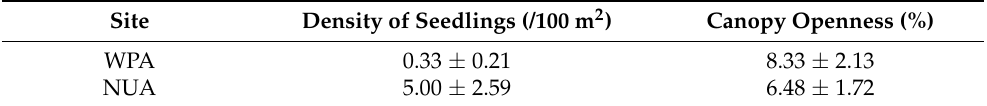
Figure 6. Comparison of coverage and height of Sasa nipponica between the wildlife protected area (WPA) and the neighboring unprotected area (NUA) from 2012 to 2013. Deer hunting was banned at WPA until the 2012 survey, but the ban was lifted before the 2013 survey. The boxplots indicate the first quartile, median, and third quartile. Different letters indicate significant difference between sites in each year ( α = 0.05).